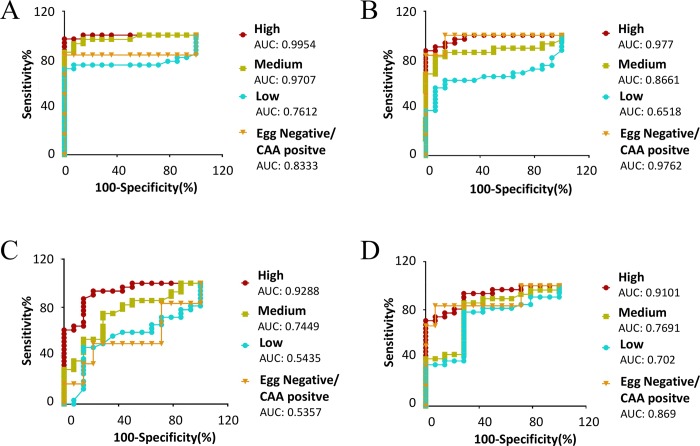
Receiver operating characteristic (ROC) curves.Areas under the ROC curve determine the predicative performance of adult excretory/secretory (ES) products (A), tegument proteins (B), egg ES products (C) and soluble egg antigen (SEA) (D) to detect antibodies in the urine of individuals with differing intensities (high, medium, low and egg negative/CAA positive) of Schistosoma haematobium infection. A control group of urine from non-endemic individuals who had never been infected with S. haematobium was included.